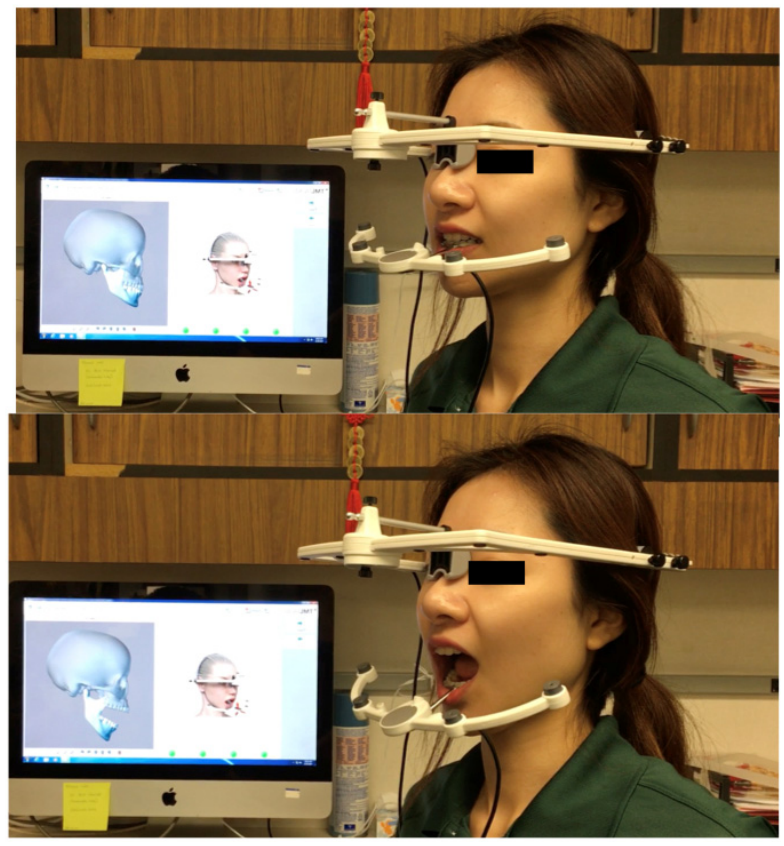
Figure 3. Extra-oral photos with SICAT JMT+. The maxillary mouthpiece was positioned to orientate the CBCT and maxillary position (not seen). Mandibular tracking device alone.